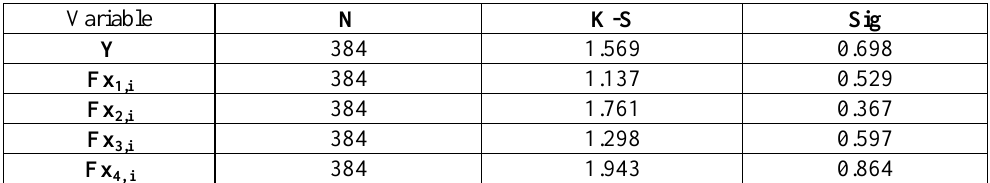
Table. 5. Results of Test of Normality of Dependent Variable of Research upon Normalization